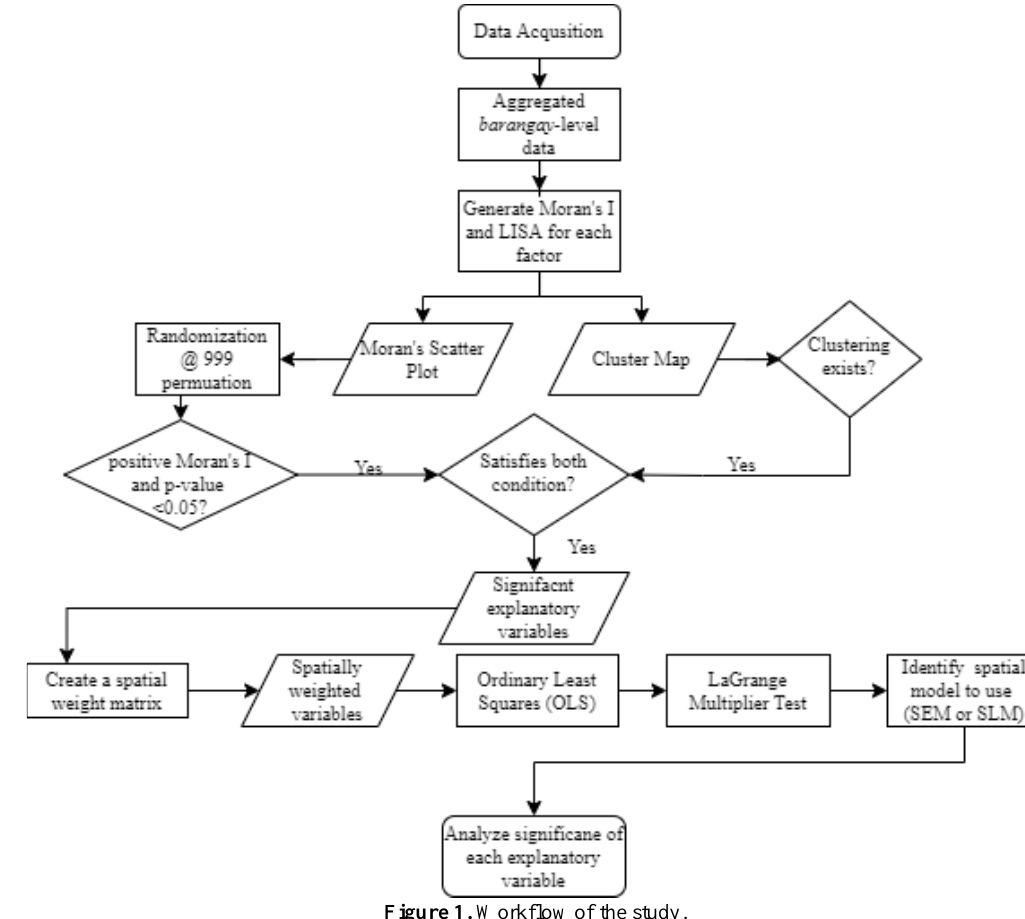
Figure 1. Workflow of the